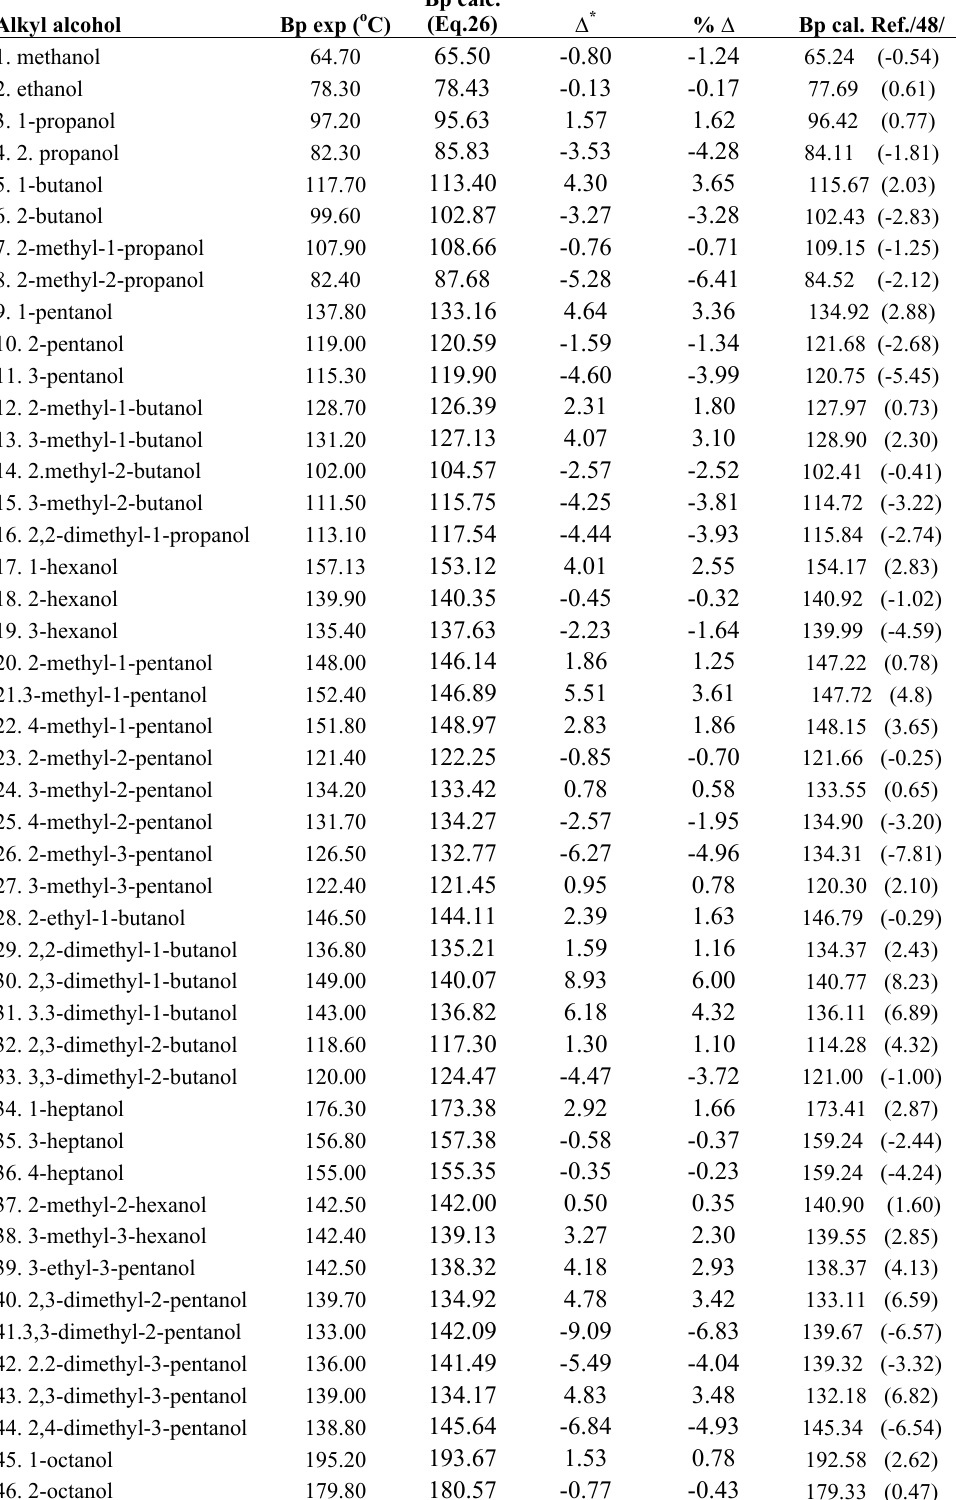
Table 8 . Experimental and Calculated Bp of Alkyl Alcohols in full